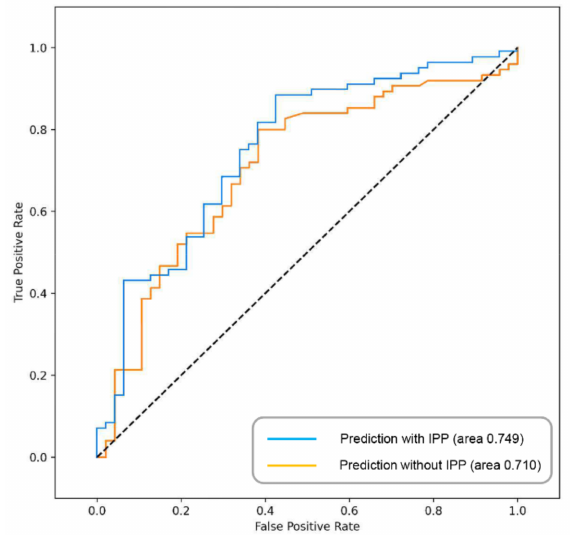
Figure 3. ROC analysis of machine learning prediction model with or without intravesical prostatic protrusion. ROC: receiver operating